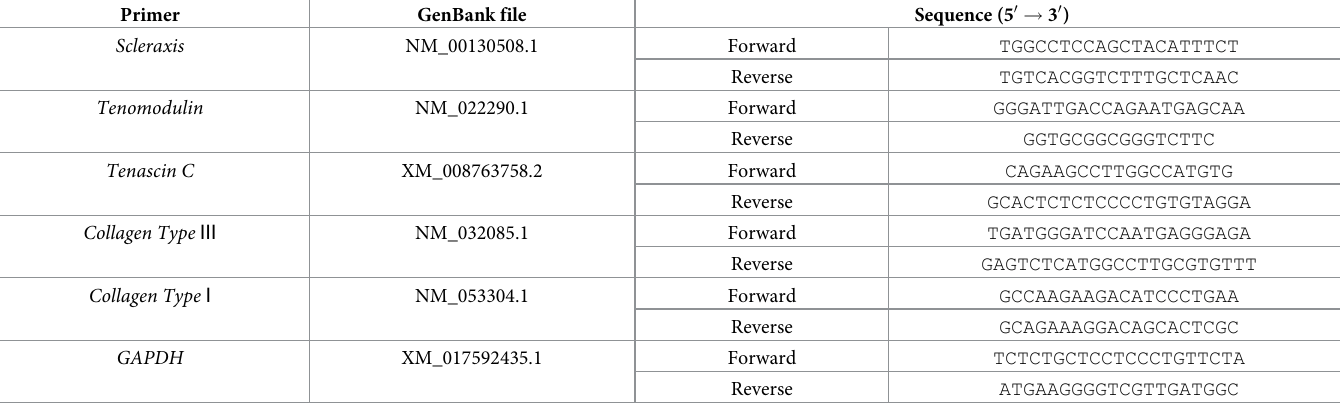
Table 1. Primer sequence information. The sequences below were identified in NCBI’s Primer-BLAST.